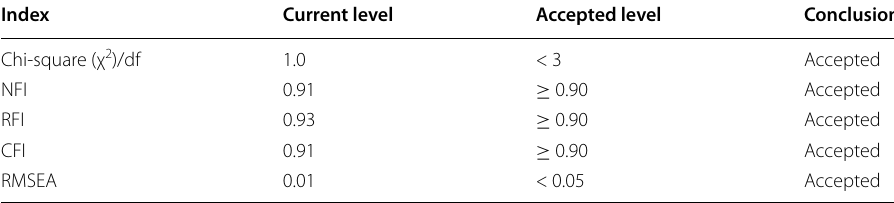
Table 6 Fit measures for model of test